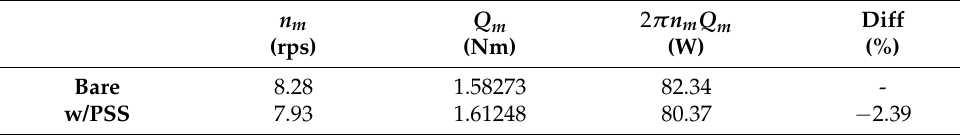
Table 6. Comparison of performances with and without the initially designed PSS by CFD.